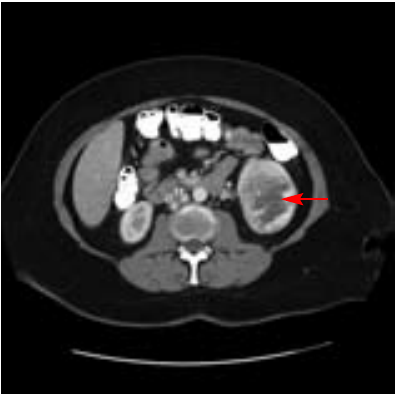
Figure 4. Renal cell carcinoma, clear cell type. Microscopic examination of the kid- ney tumor shows alveolar architecture of the cells with clear cytoplasm and distinct cell boundaries in a background of delicate vasculature. (H&E stain; magnification